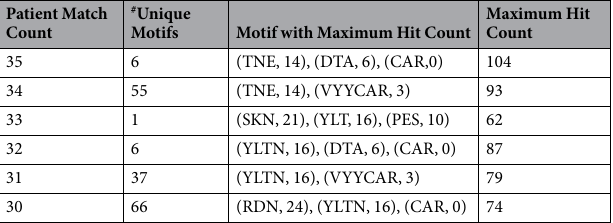
Table 1. Each row of the table corresponds to DOM motifs associated with a patient match count ranging 30 and 35. The patient match counts are listed in the first column. The second column contains the number of DOM motifs associated with each match count. The third column contains the DOM motif that matches the maximum number of sequences for a particular match count. The number of sequences matched by the third- column column motif is listed in the final column of the table. All motifs are stated in a parenthesis notation where ( S , x ) represents an non-gapped subsequence S that is located x amino acids to the left of the CDR3. The Prime Motif appears in row 1, column 3 of the table.